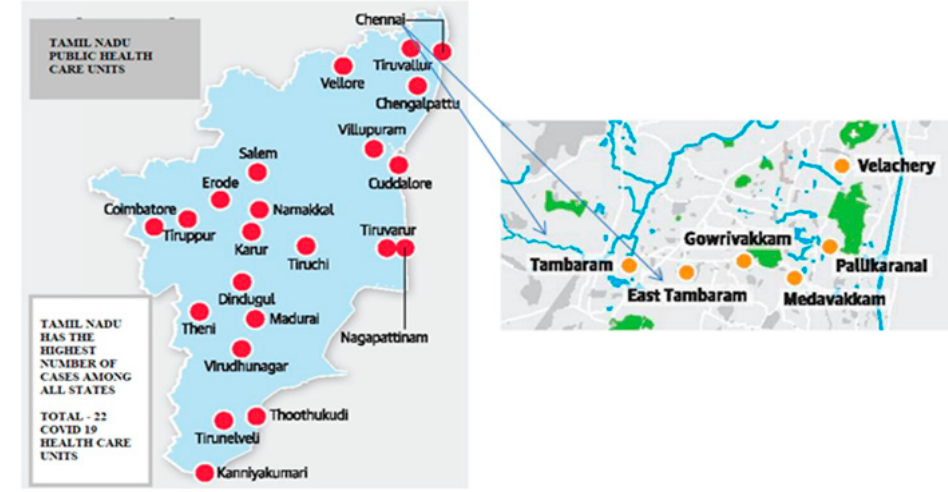
Figure 1. Distributed map of public health care centers in Chennai city, Tambaram zone.